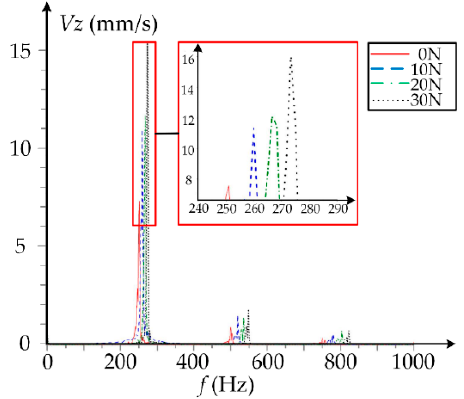
Figure 10. The bearing vibration under different radial loads when L = 1.9.